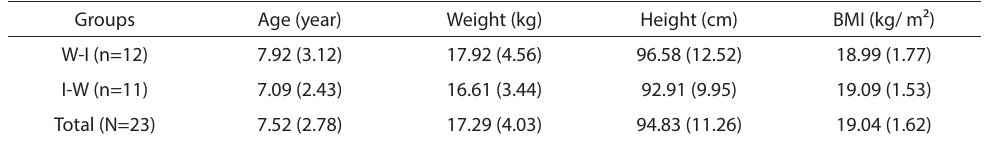
Table 2. Physical characteristics of the groups - Mean